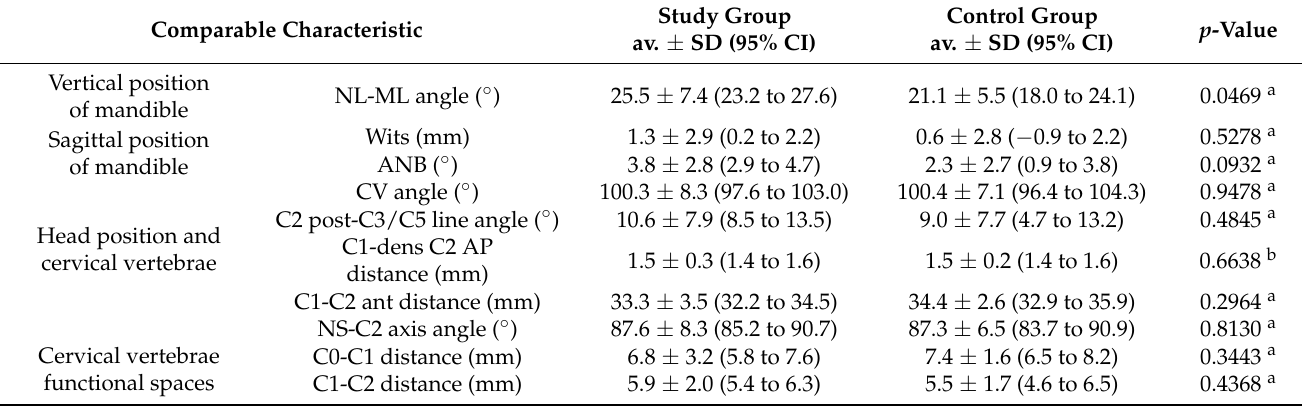
Table 3. The comparison of the examined parameters within the cervicofacial skeleton during the initial examination between the study group and the control group.